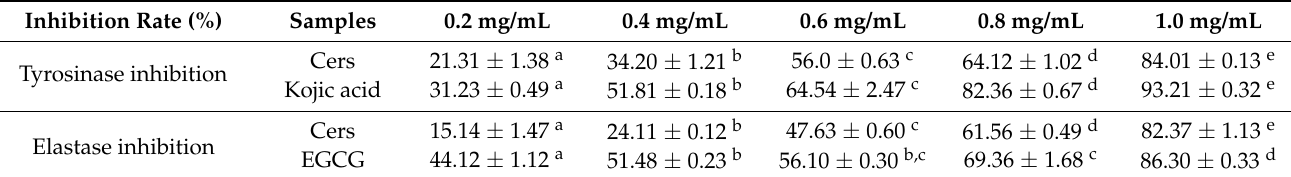
Table 6. Anti-tyrosinase and anti-elastase activity of purified Cers. Inhibition Rate (%) Samples Tyrosinase inhibition Elastase